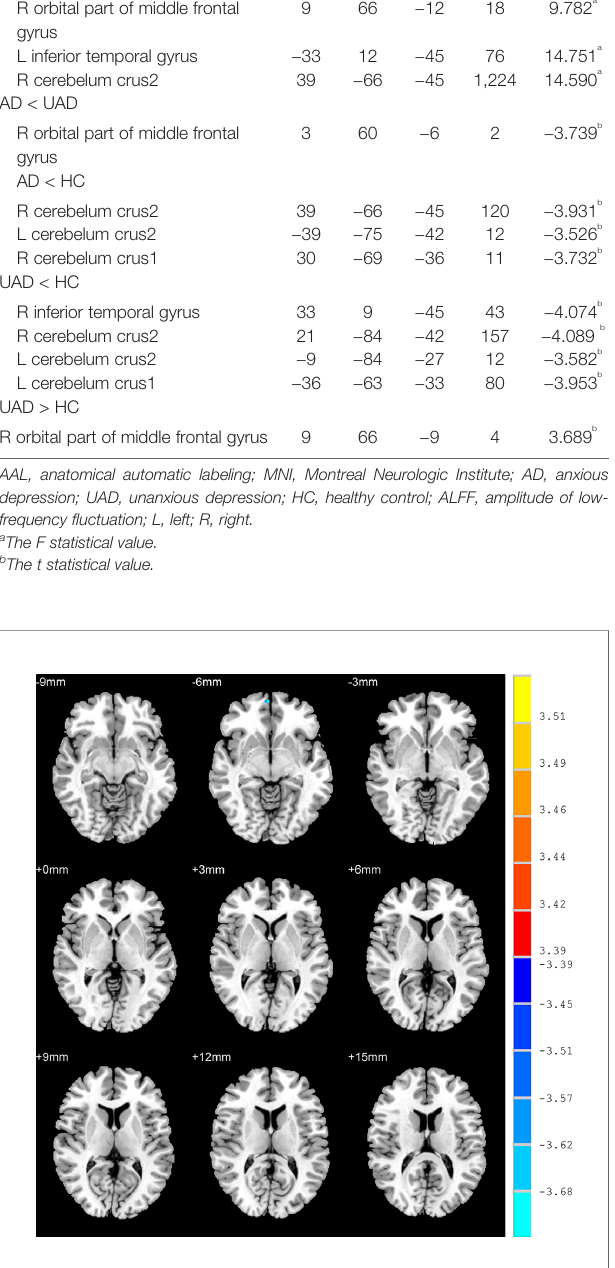
FIGURE 2 | Brain regions show the differences in the amplitudes of low- frequency fl uctuations between anxious depression group and unanxious depression group. The color bar signi fi es the t-value of the independent t - tests between the two groups with p < 0.001 and corrected for multiple comparisons using